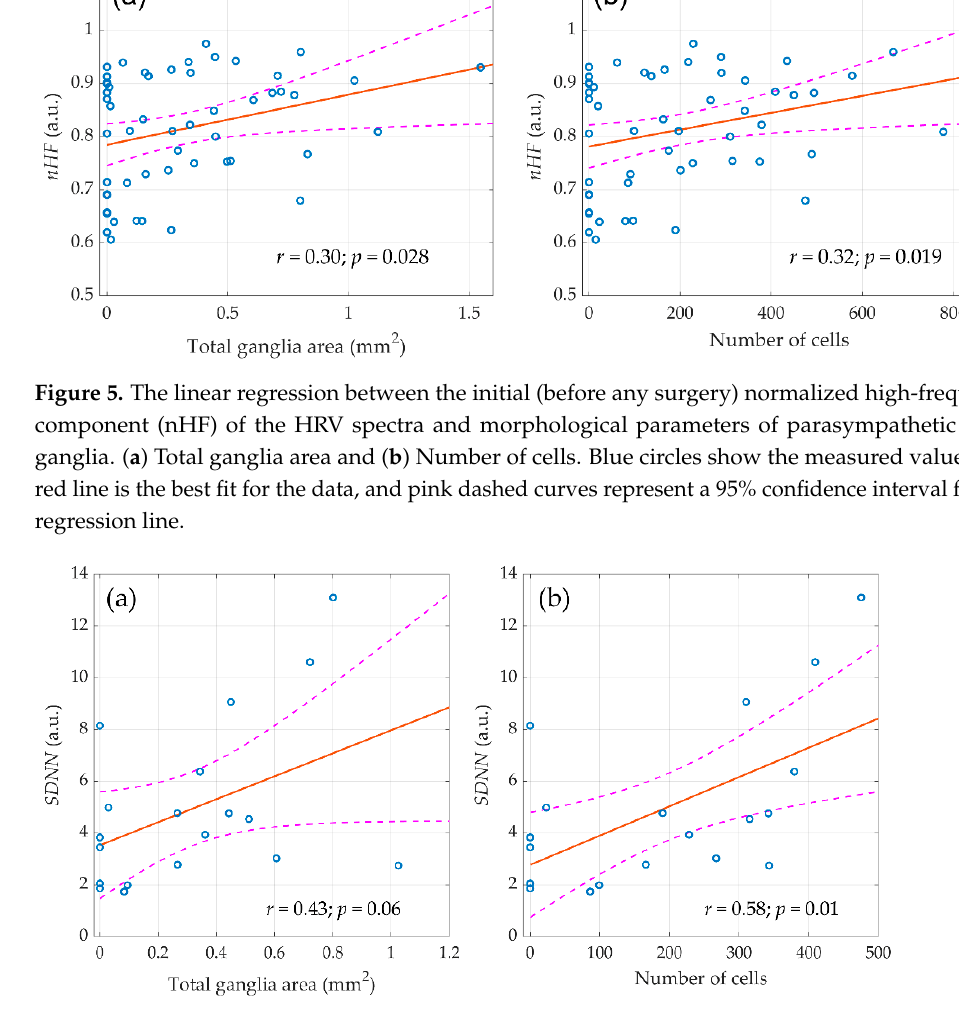
Figure 5. The linear regression between the initial (before any surgery) normalized high-frequency component (nHF) of the HRV spectra and morphological parameters of parasympathetic atrial gan- glia. ( a ) Total ganglia area and ( b ) Number of cells. Blue circles show the measured values, the red line is the best fit for the data, and pink dashed curves represent a 95% confidence interval for the regression line.